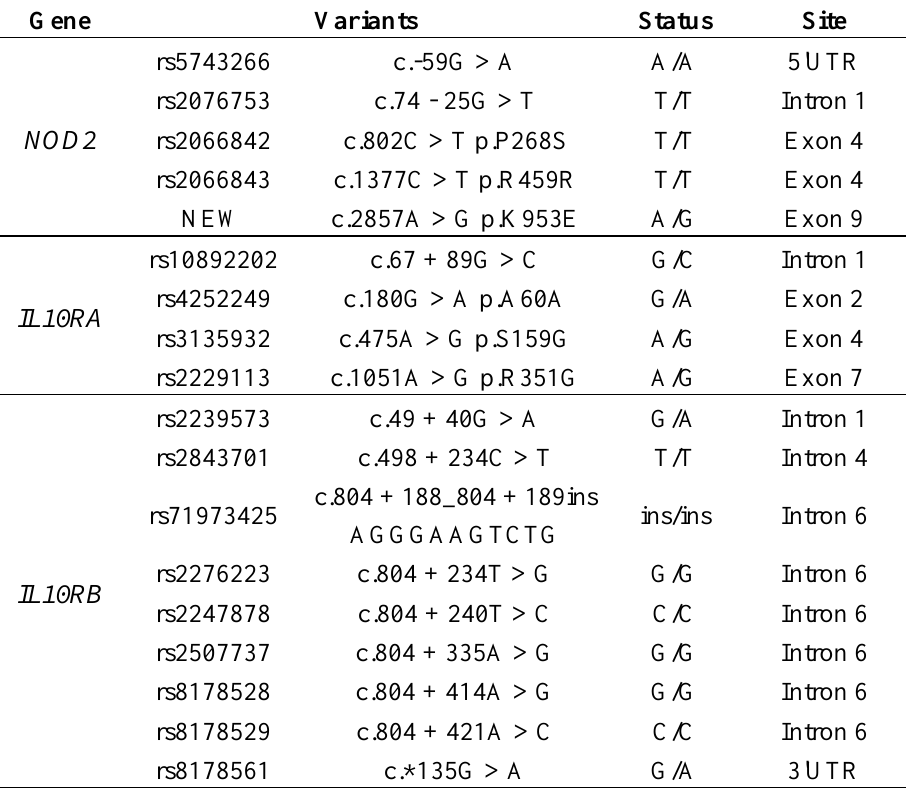
Table 1. Genetic variant in the analyzed genes, relative genotyping and